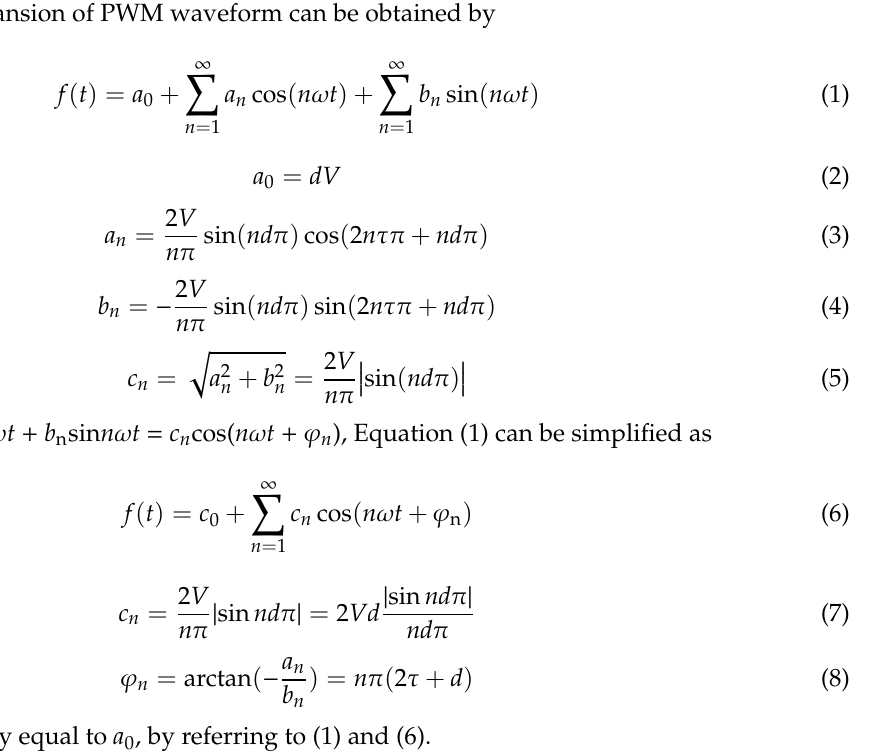
Figure 3. Typical pulse width modulation (PWM) waveform.